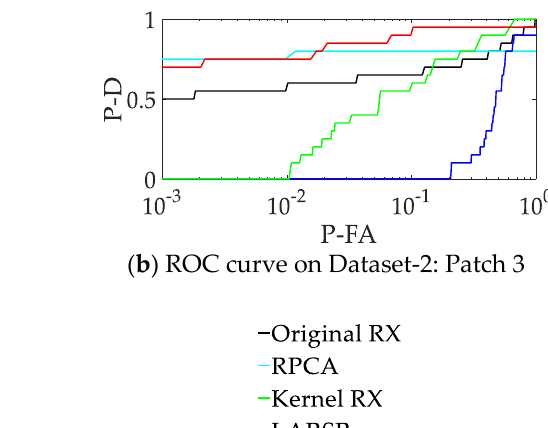
( a ) ROC curve on Dataset-1: Patch 7 ( b ) ROC curve on Dataset-2: Patch 3